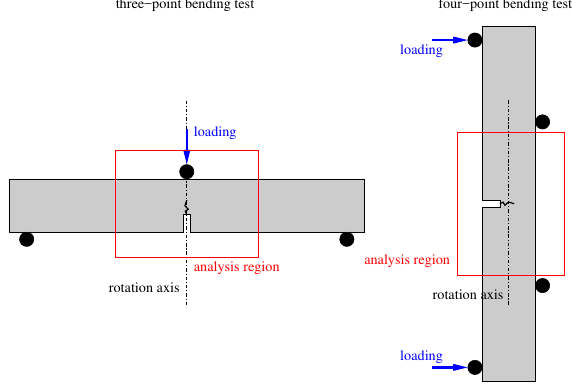
Figure 2. Basic principles of the loading